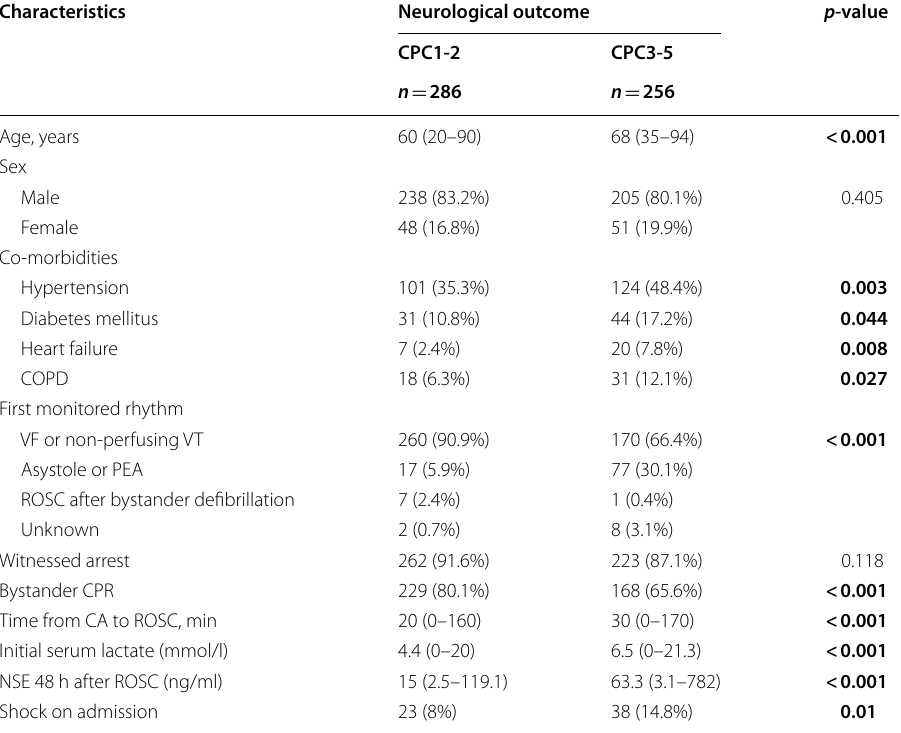
Demographic and clinical characteristics of 542 patients of the TTM-trial according to neurological outcome established with CPC score. Continuous variables are indicated as median (range), while categorical characteristics are reported as number (frequency). Statistically significant p -values (< 0.05) are highlighted in bold in the table. Abbreviations as in Table 1